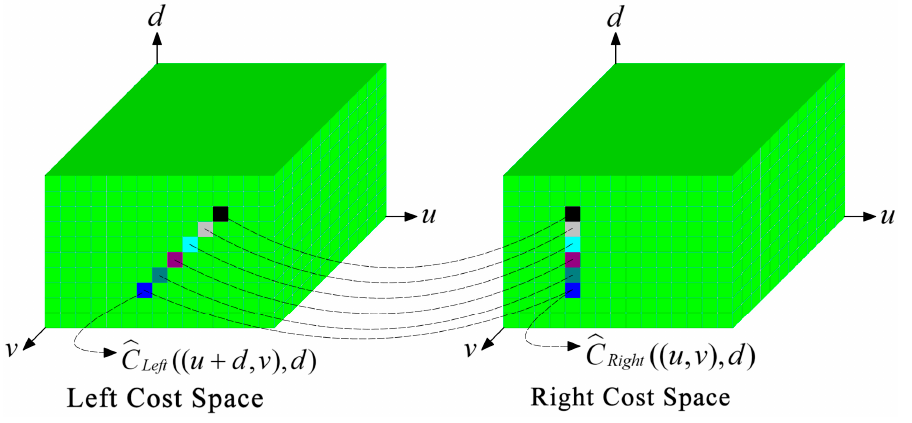
Figure 4. Schematic diagram of cost space conversion.